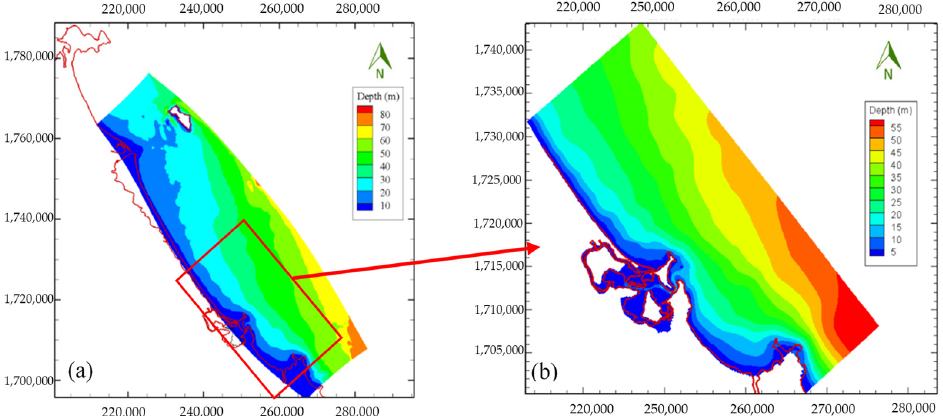
Figure 7. Initial numerical bathymetry for ( a ) large domain, ( b ) finer domain.